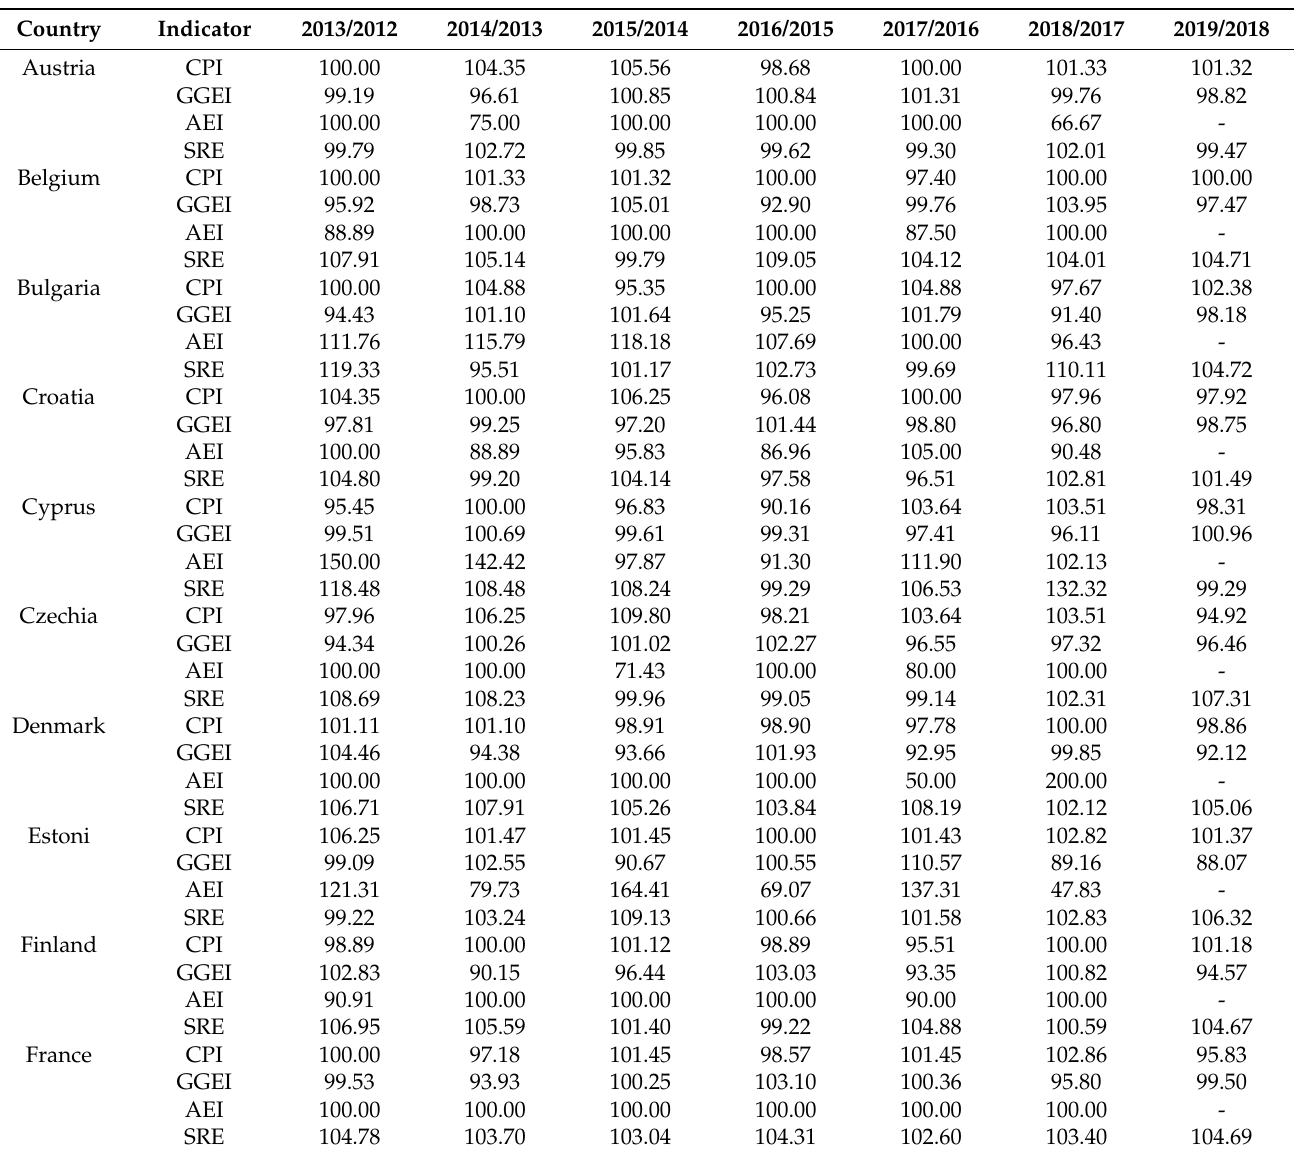
Table 2. Comparison of the dynamics of the analysed indicators in 5 selected countries in the years